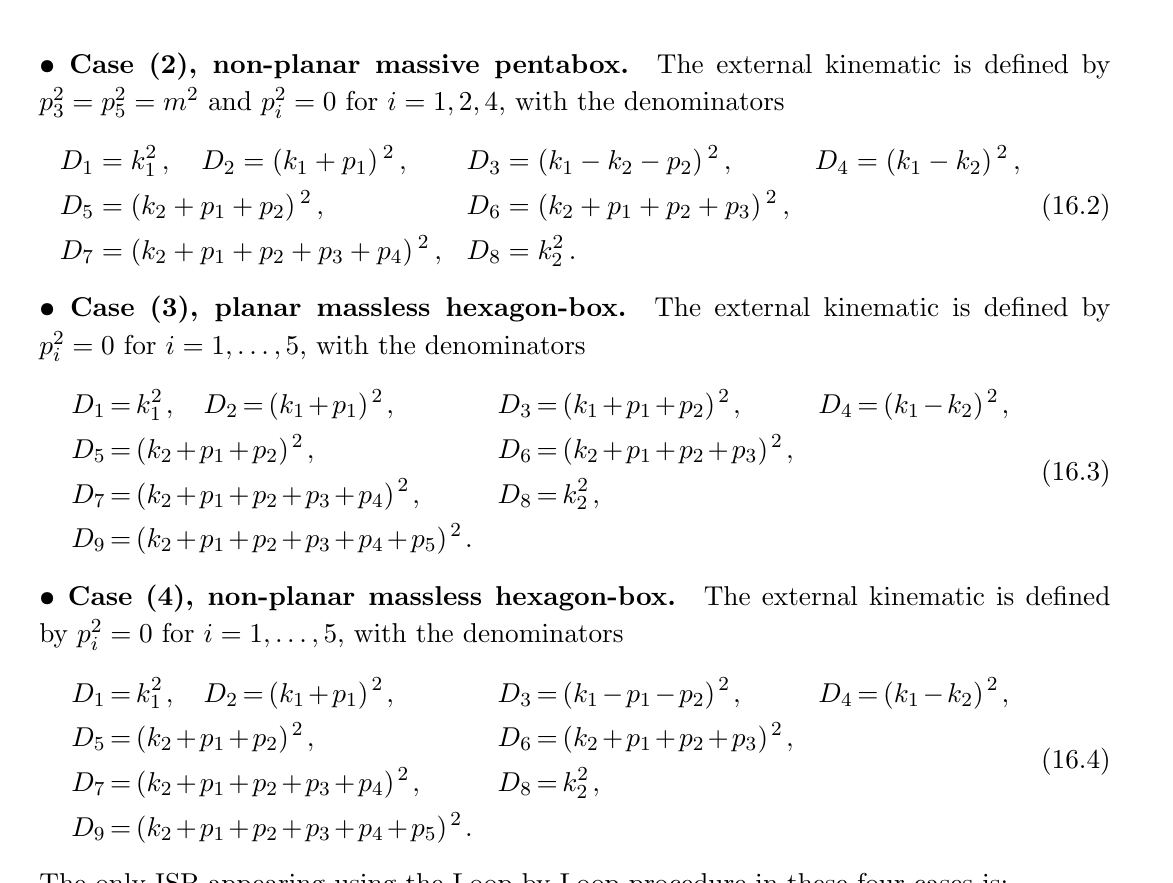
Figure 19. Planar and non-planar pentabox with two external masses (1,2), as well as planar and non-planar hexagon-box